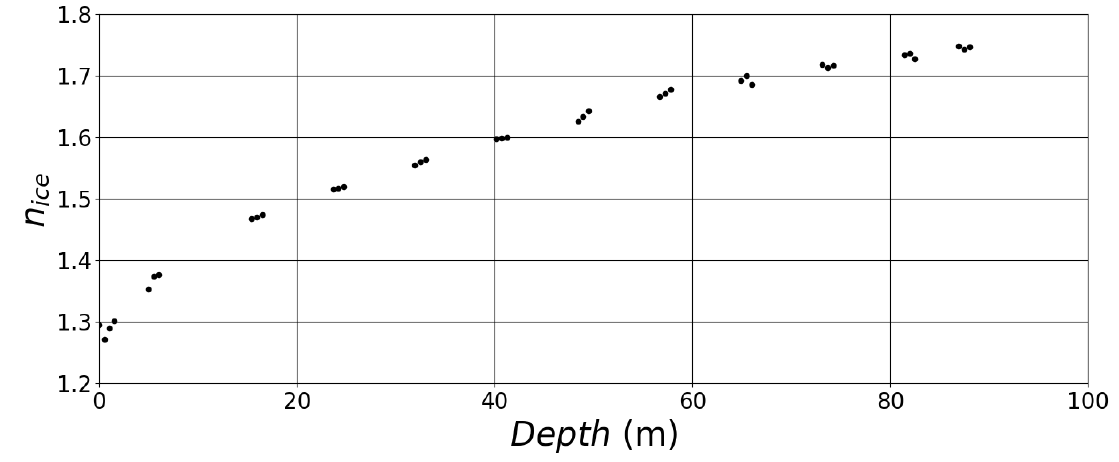
Figure 8. Refractive index as a function of ice depth, as reported in Table 4 of Ref [45], estimated from North Greenland Eemian Ice Drilling (NEEM) camp data.